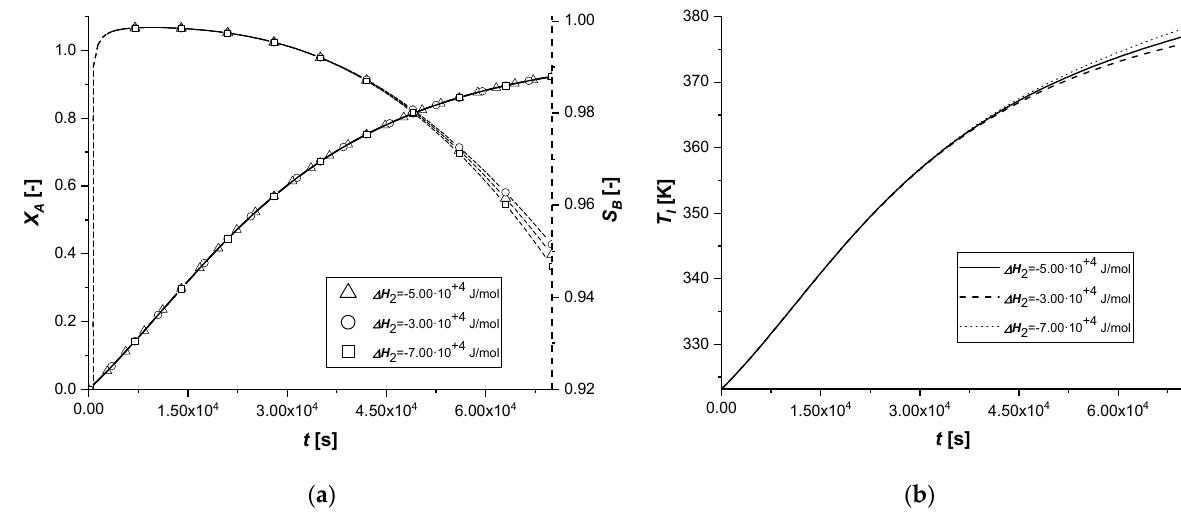
Figure 9. EW ∆ rH 2 investigation. ( a ) Bulk profiles over time of X A and S B . ( b ) Bulk profile of T l over time.